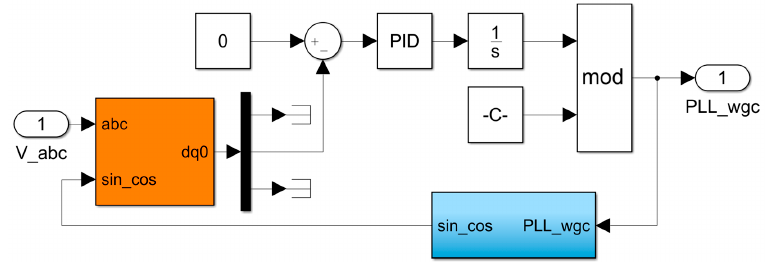
Figure 5. Simulation model of phase locked loop.